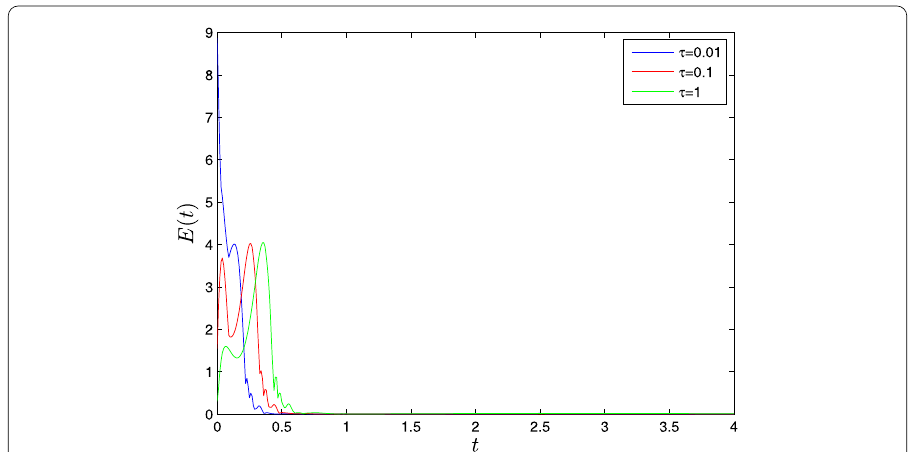
Figure 3 Time evolution of the lag synchronization error E ( t